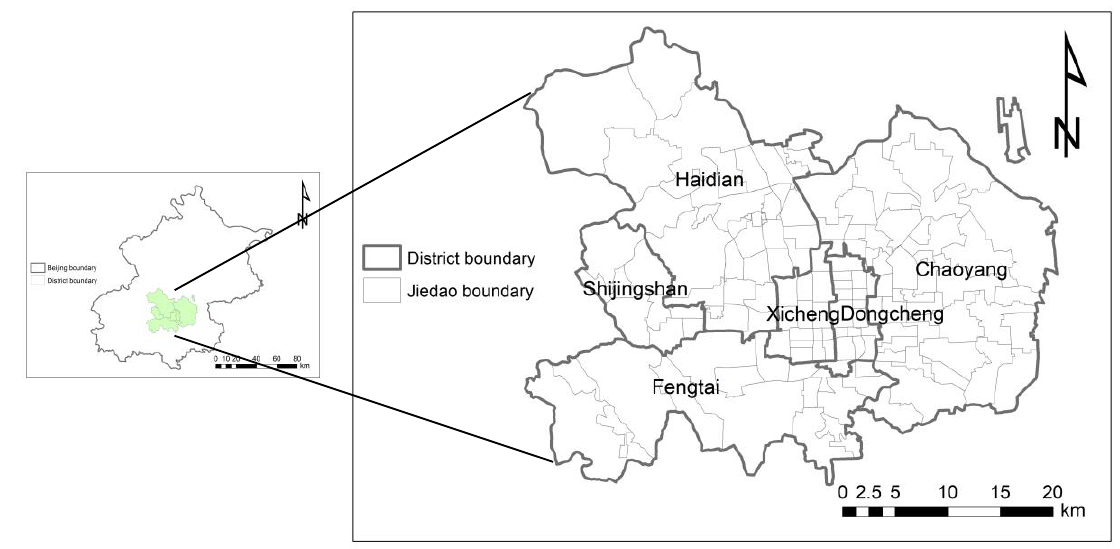
Figure 1. Study area, composed of six districts and 130 jiedao (i.e., a city block, which is the smallest census unit).